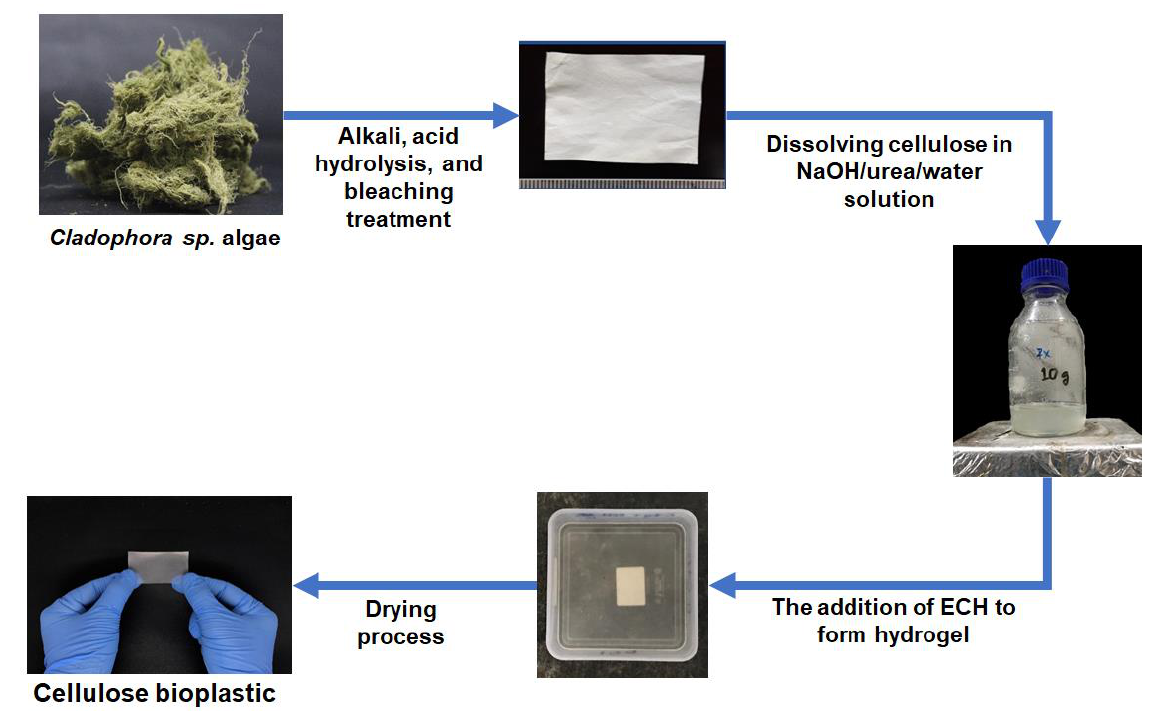
Figure 1. The scheme of the cellulose bioplastics preparation from Cladophora sp. algae. In this study, Cladophora sp. algae cellulose was dissolved in NaOH/urea/water solution. ECH at various concentrations was used as the cross-linking agent to form the hydrogel. During the preparation of the cellulose hydrogel, the mixture of cellulose solution and ECH exhibited an exothermic reaction due to the heat produced during the gelation process. Cellulose hydrogel was formed overnight after some rest time through the chemical cross-linking between the hydroxyl groups of cellulose and ECH. According to Ciolacu et al., the chain entanglements of cellulose were also formed during this process [25]. In order to remove the chemical residue, the cellulose hydrogel was immersed in water until its neutral pH was reached. Finally, cellulose bioplastics were achieved after the process of drying the cellulose hydrogels. The obtained cellulose bioplastic samples at various ECH concentrations are presented in Figure 2. The cellulose bioplastic samples were placed with a background of Institut Teknologi Bandung’s logo. According to the visual inspection, the optical clarity of cellulose bioplastics increased with the increase in ECH concentrations. The C-ECH10 sample exhibited the highest opacity compared to the other bioplastic samples. The opacity of cellulose bioplastic is affected by the cellulose concentration in the bioplastic, which is related to the tendency of cellulose molecules